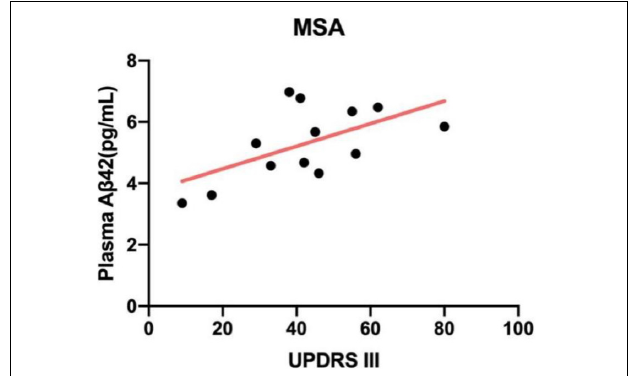
FIGURE 2 | Correlation between plasma A β 42 and UPDRS part III scores in patients with MSA. The levels of plasma A β 42 were positively related to UPDRS part III ( r = 0.589, p = 0.03). MSA, multiple system atrophy; A β 42, β -amyloid 42; UPDRS part III, Unified Parkinson’s Disease Rating Scale part III.